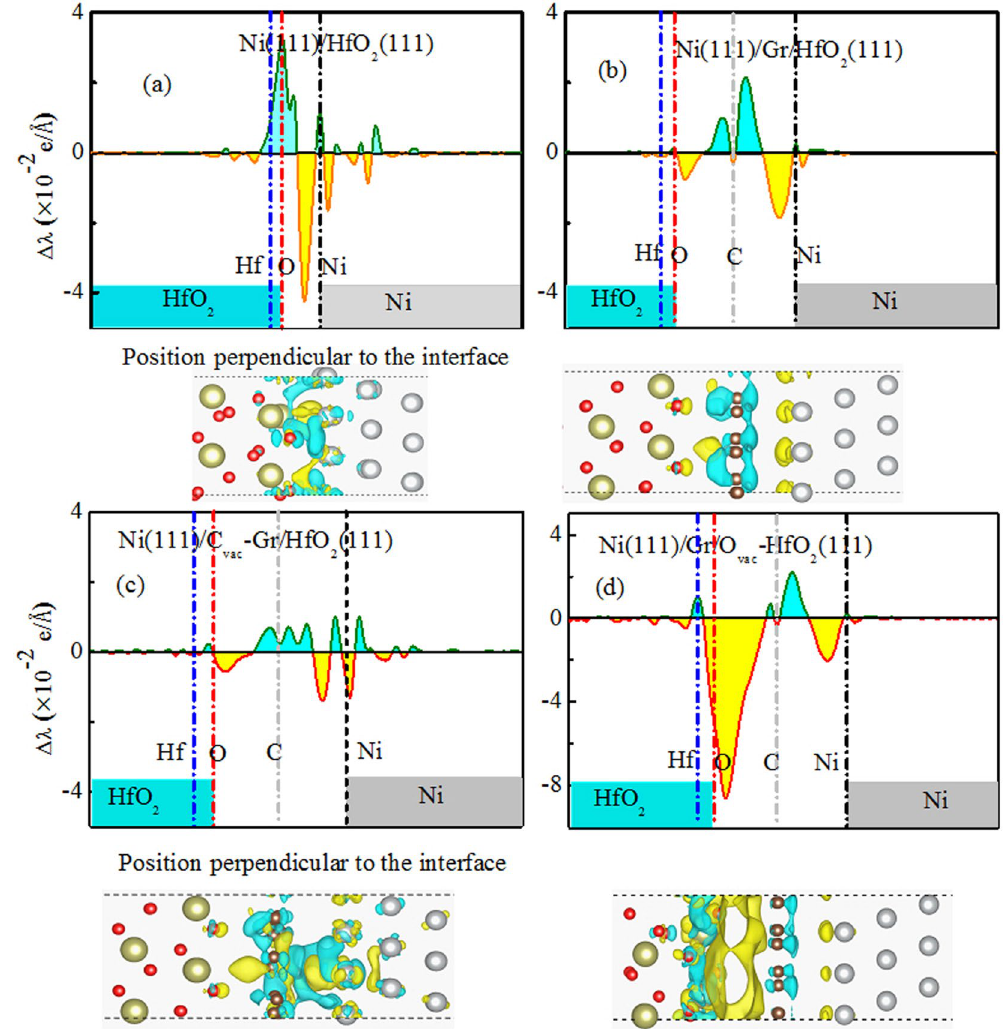
Figure 3. Plane averaged electron density difference of valence electron ∆λ z ( ) for ( a ) Ni(111)/HfO 2 (111), ( b )